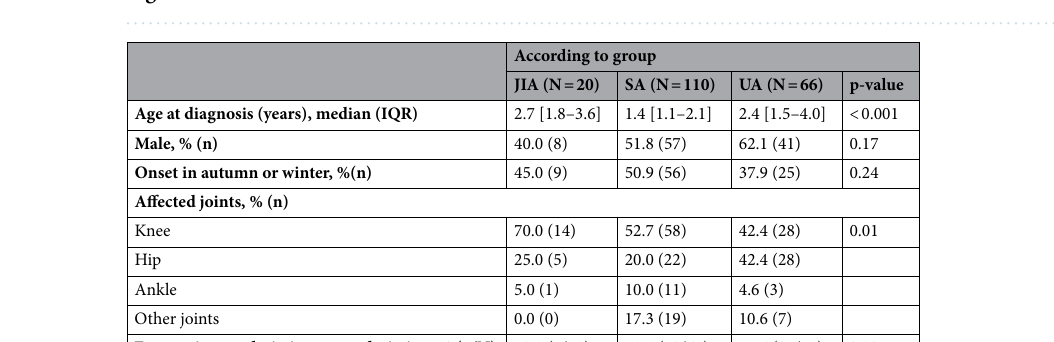
Figure 1. Flow chart.